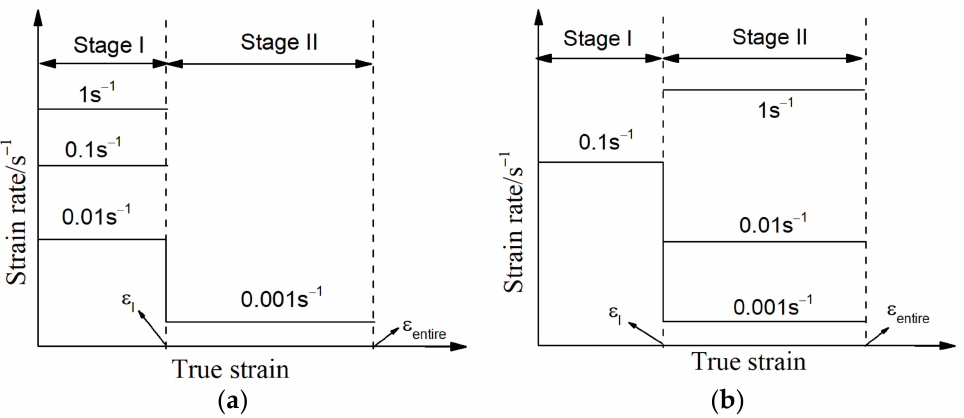
Figure 1. Experiment schemes of the researched alloy including: ( a ) type I: the strain rates changed from different values of . ε I into the different values of